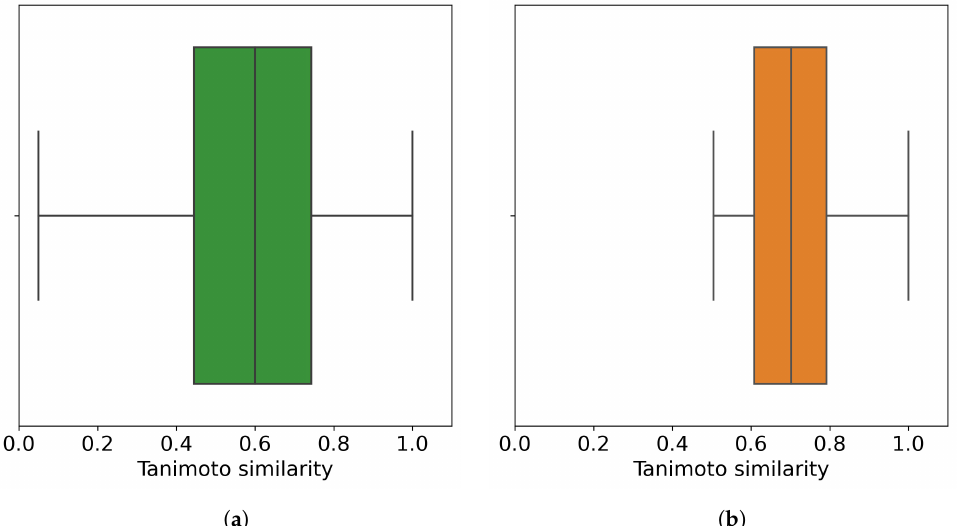
Figure 3. Distribution of the chemical similarity of molecules. ( a ) Before the outlier detection method (all 50,555 molecules); ( b ) after the outlier detection method, where 32,971 non-outlier molecules are retrieved at an outlier cutoff of 0.5. Each point in the corresponding boxplot is a molecule with its similarity to its closest molecule (other than itself). In total, 50% of molecules, either all of the molecules or non-outlier molecules, have their most similar molecule with similarity values less than 0.6 and 0.7,